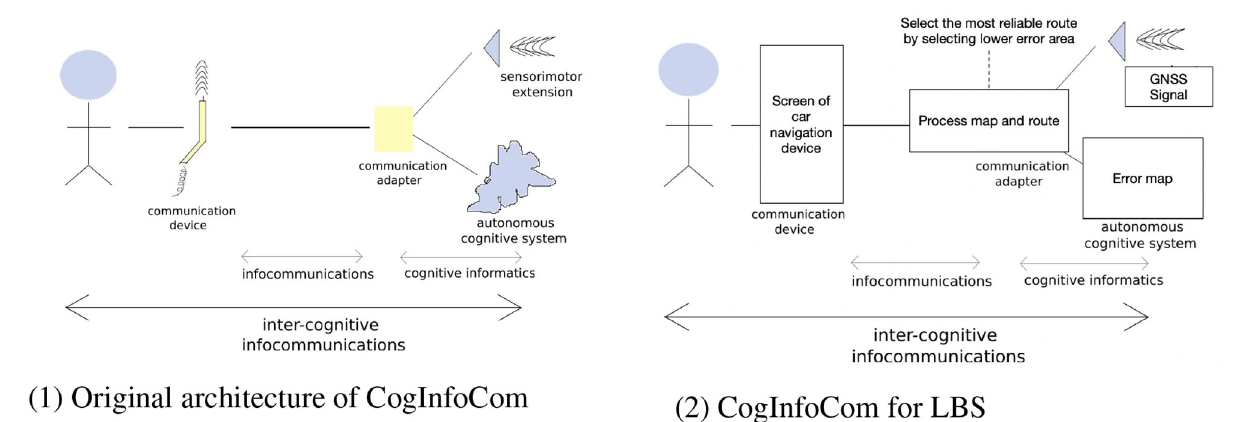
FIGURE 1 | Error mapping for the CogInfoCom architecture.